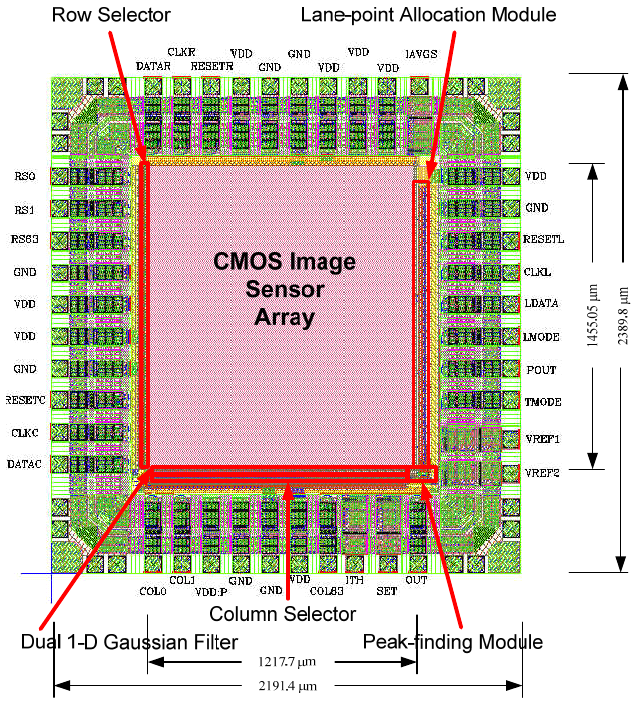
Figure 12. Layout diagram of the proposed CMOS imager.